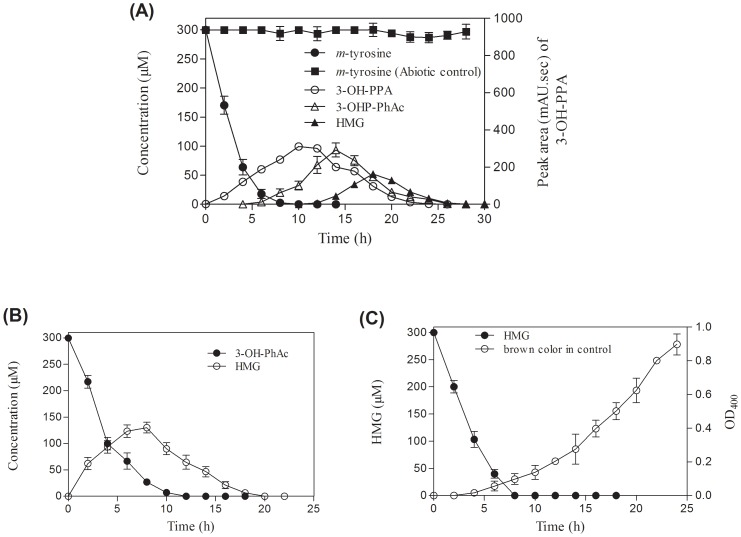
Degradation kinetics of m-tyrosine, 3-hydroxyphenylacetate, and homogentisate by m-tyrosine-induced cells of strain SSC5.(A) m-Tyrosine degradation kinetics. (•), m-tyrosine; (○), 3-OH-PPA; (Δ), 3-OH-PhAc; (▴), HMG; (▪), m-tyrosine in abiotic control. (B) 3-Hydroxyphenylacetate degradation kinetics. (•), 3-OH-PhAc; (▪), HMG. (C) Homogentisate degradation kinetics. (•), HMG; (○), brown color (as measured by the OD400) in control. Values are presented as arithmetic mean of data obtained from experiments carried out in triplicate; error bars represent standard deviation.